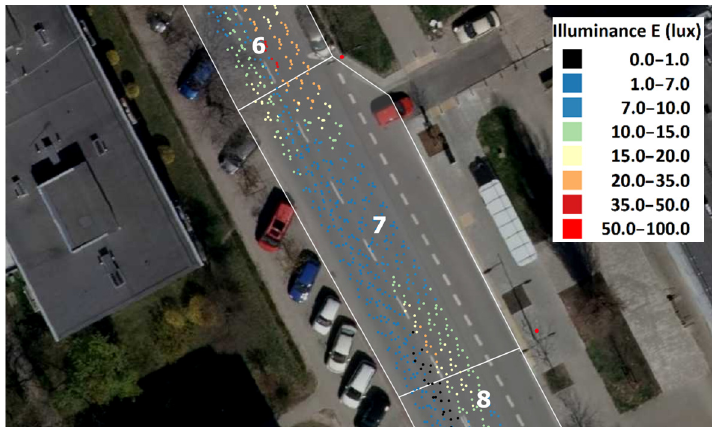
Figure A5. Example of five illuminance measurements in field No. 7.